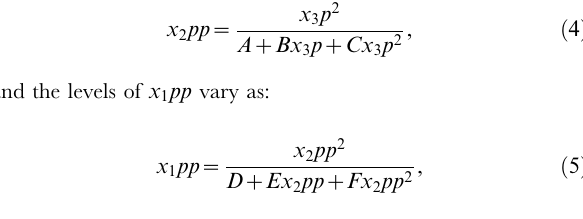
Table 3. State variables for model 2.